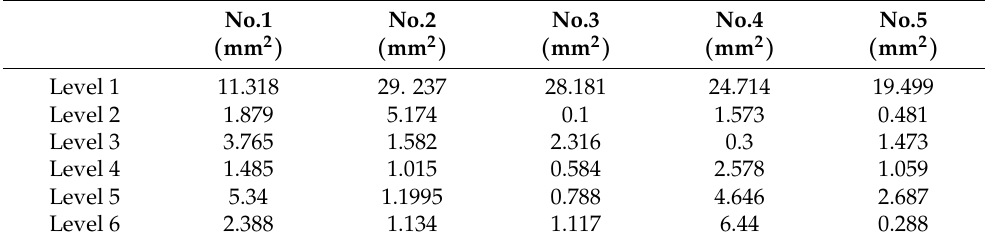
Table 5. Model predictions and actual results error. Figure 16. Average ignition delay time.